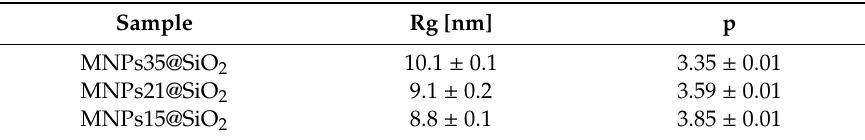
Table 4. Structural parameters of nanocomposites obtained by SANS.